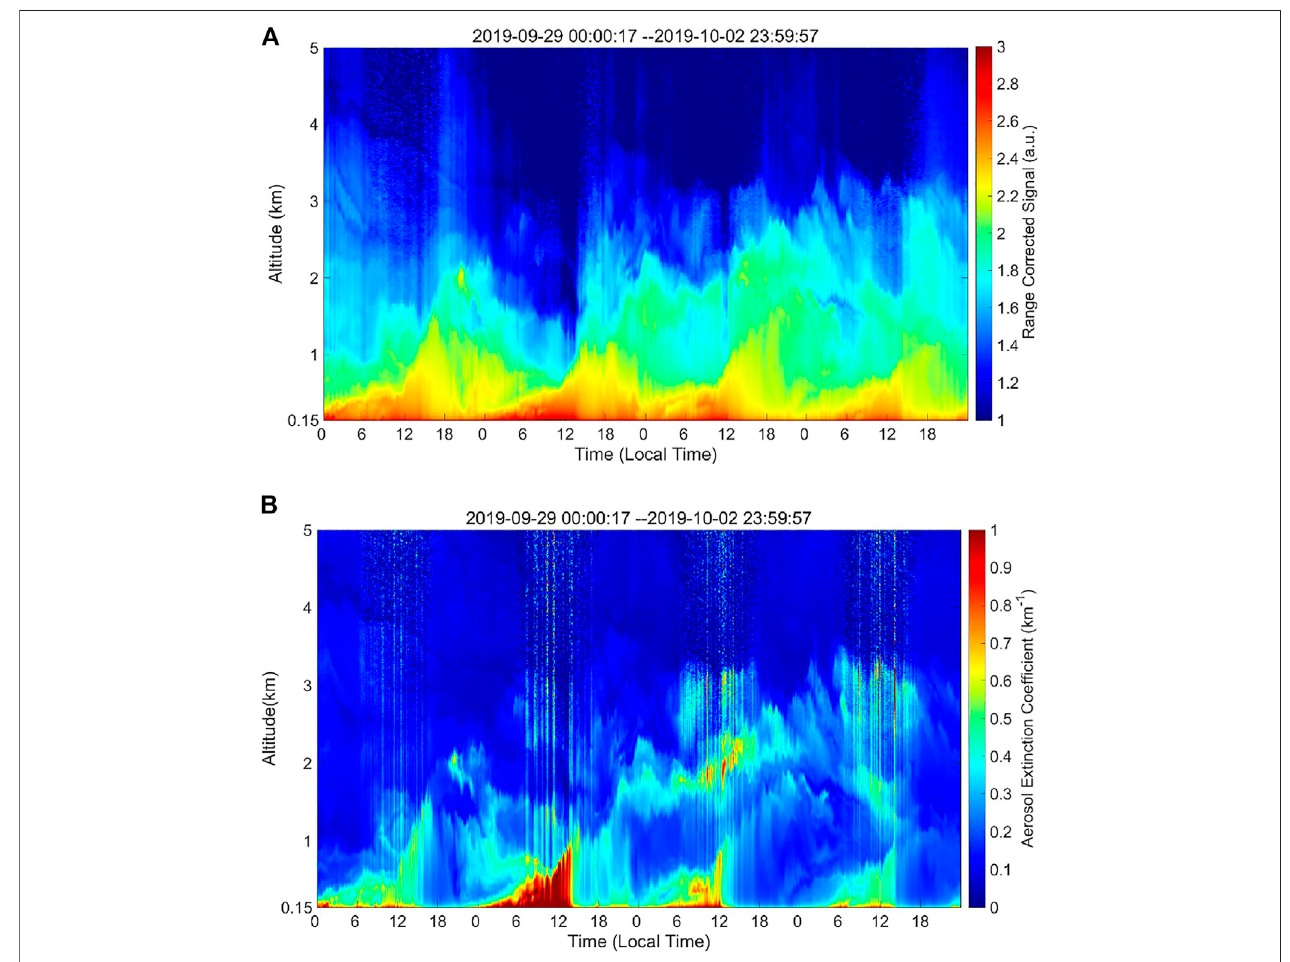
FIGURE 9 | (A) THI fi gure of range corrected signal at 532 nm from 29 September to 2 October 2019. (B) THI fi gure of extinction coef fi cient at 532 nm from 29 September to 2 October 2019.